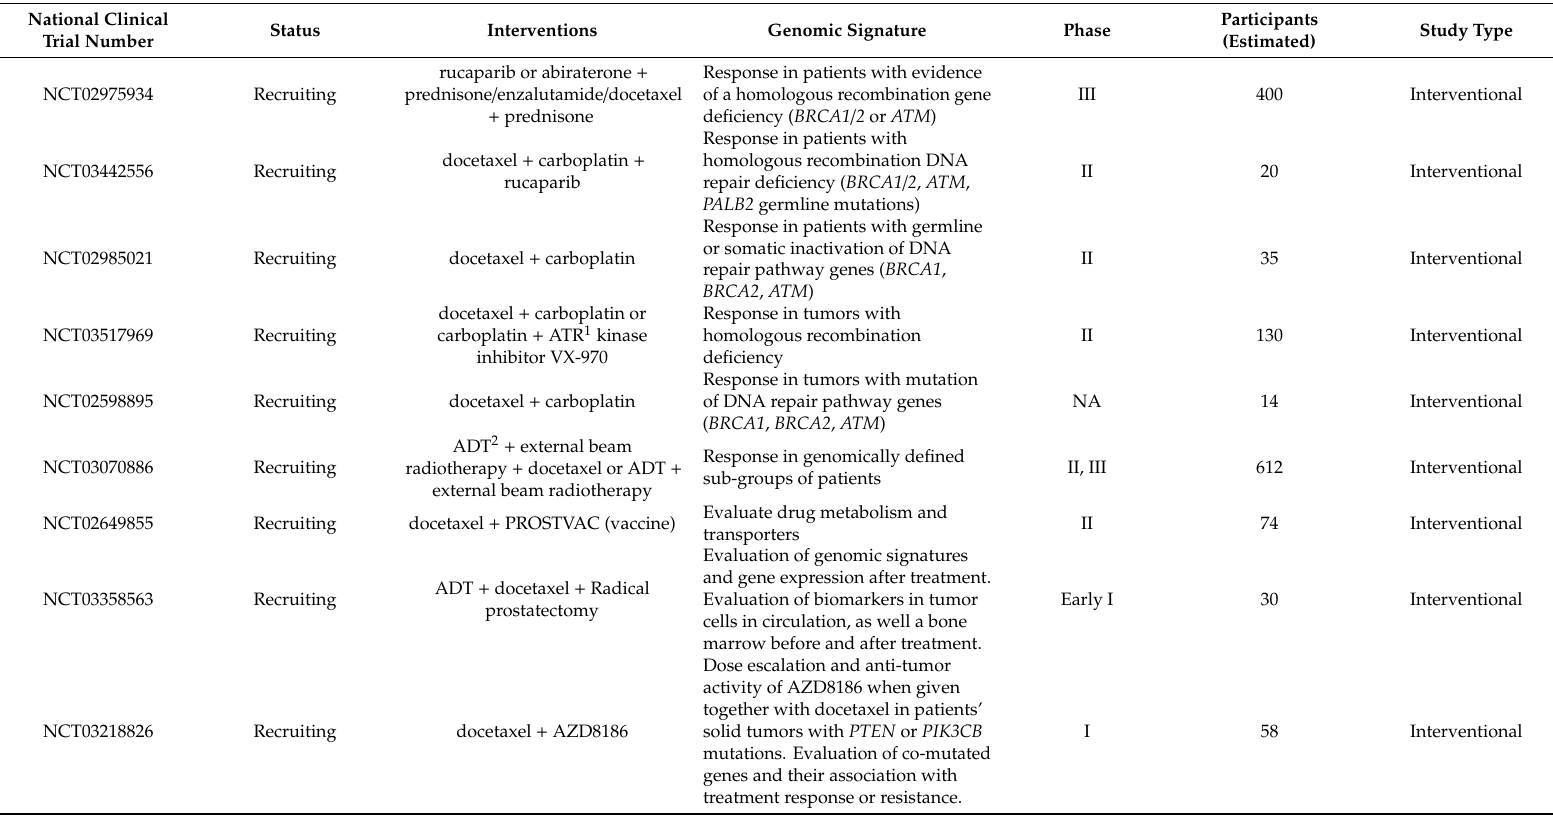
Table 3. Ongoing clinical trials for docetaxel treatment in prostate cancer (“recruiting”, “active” / ”not recruiting”, “not yet recruiting”)